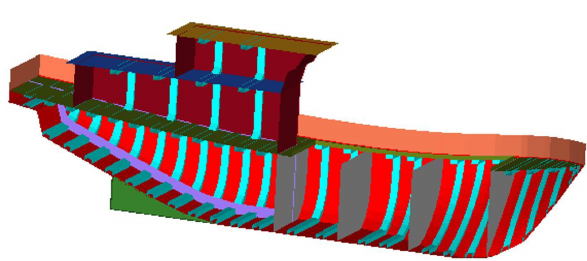
Figure 23: The frame structure design of the ship simulation model (without longitudinal